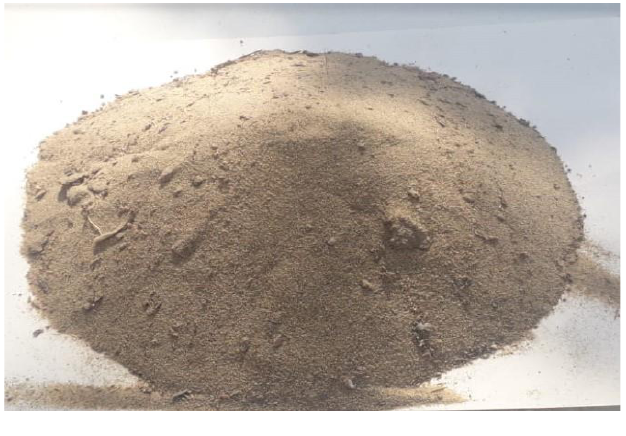
Fig. 1. Desert sand